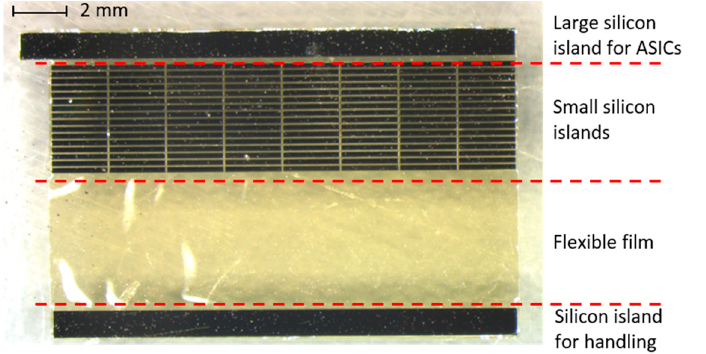
Figure 9. DBS demonstrator released after the fabrication. All the 80 µm-thick silicon islands are connected by the flexible film. The small silicon islands are isolated by 40 um-wide gaps.